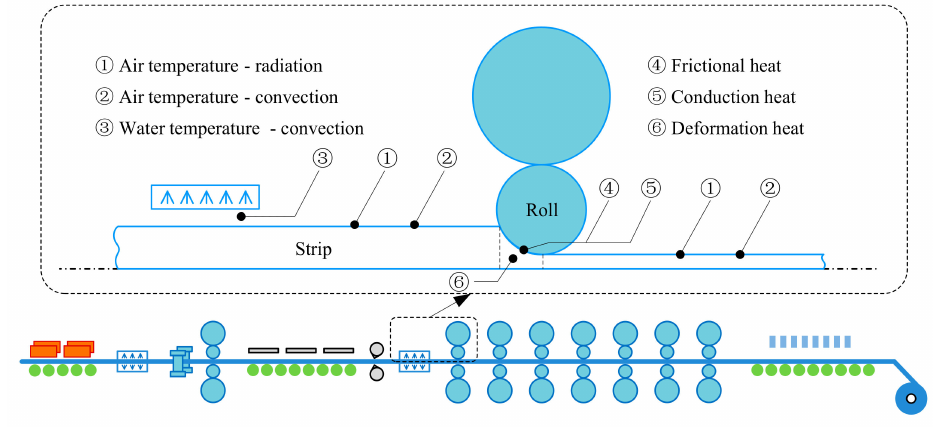
Figure 3. Heat flows during the strip